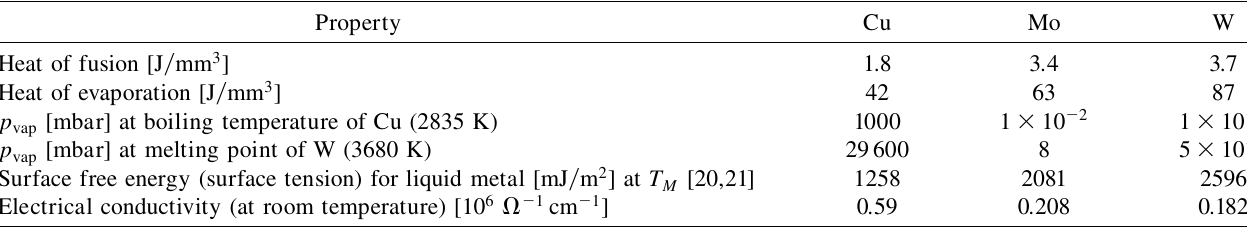
TABLE II. List of key physical material properties possibly relevant for breakdown.